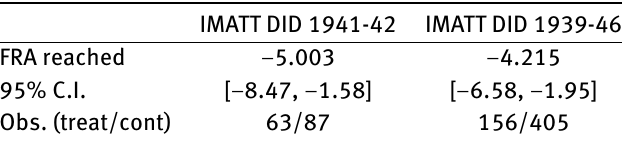
Table 2: Results Difference-in-Difference on Positive